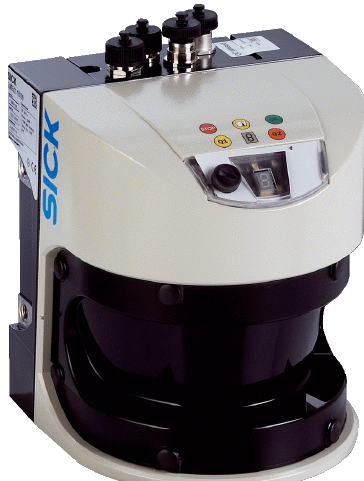
Figure 5: The Bulkscan LMS511 flow monitor